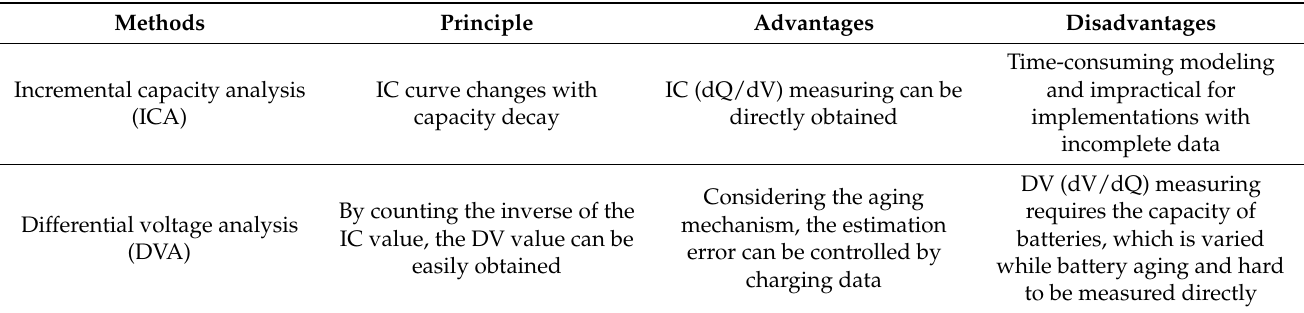
Table 2. Comparison OCV curve-based analysis methods.